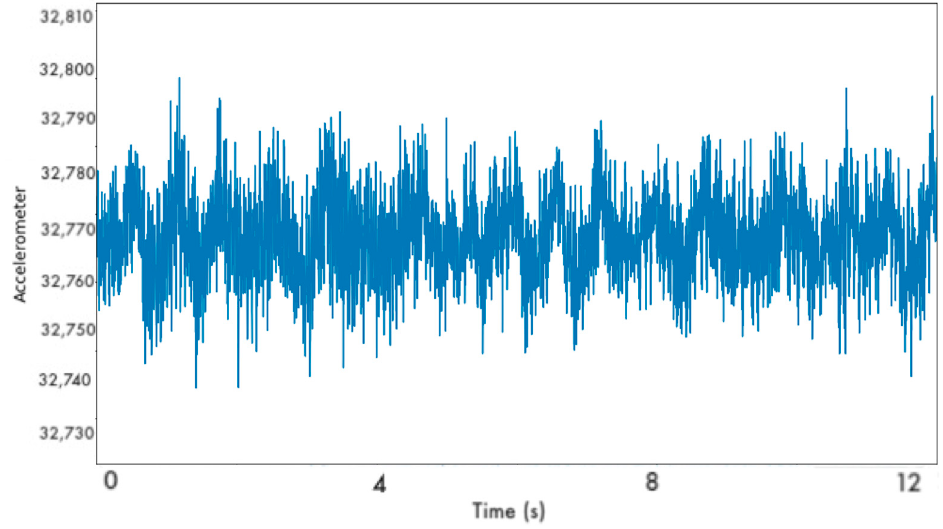
Figure 10. Reconstruction Error of the LSTM autoencoder.